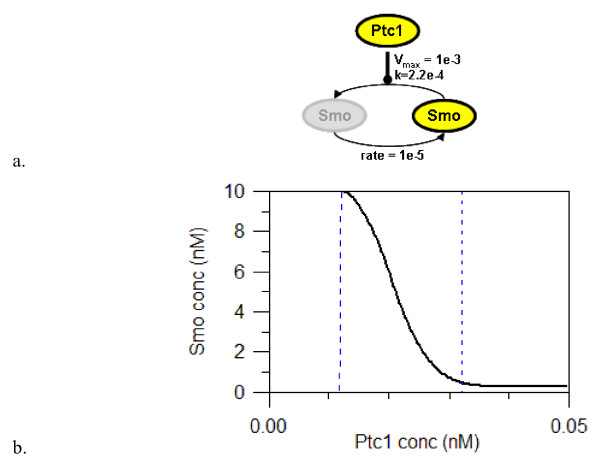
Smo inactivation catalyzed by Ptc1. In this simulation two reactions are used, one for activation from a precursor and one for deactivation of Smo. Activation occurs spontaneously at a constant rate. The inverse deactivation reaction is catalyzed by Ptc1 and is much faster when sufficient Ptc1 is present. Here Ptc1 is an essential catalyst: in its absence the deactivation reaction does not occur and Smo is continuously activated and maintained at a high level. Smo concentrations were set to be in the range of 0.0 to 10.0 nM. The concentration of Ptc1 is given as a fraction of Smo concentration. The vertical dashed lines indicate the concentration range over which the maximum inactivation rate is attained. The rules for this model include only two reactions. Reaction 1: Smo activation is proportional to the substrate concentration, Smo_inactive. The product is Smo and the rate constant is 1.0e-5. Reaction 2: Smo (active) is the substrate, Smo_inactive is the product, and Ptc1 is an activator. The rate is computed by harmonic averaging of the outcomes for the following rules: the rate is proportional to Smo concentration; the rate is zero when Ptc1 is zero or very low, and very high when Ptc1 is low or greater.